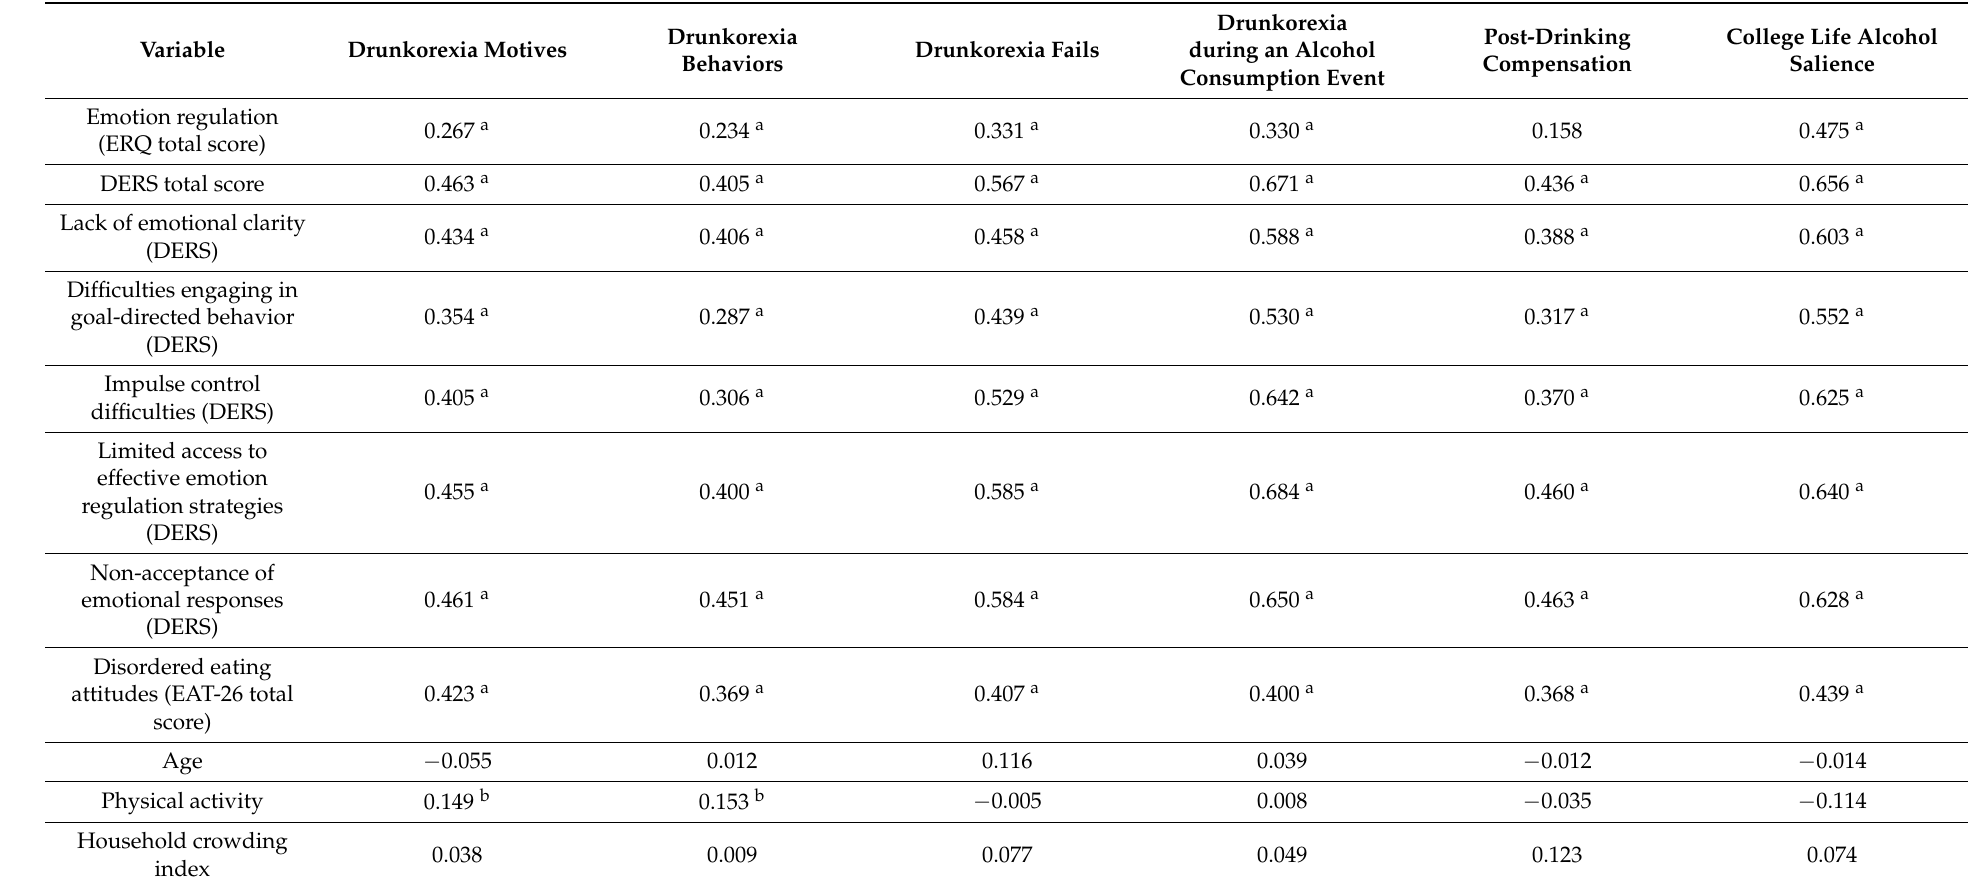
Table 2. Bivariate analysis of continuous variables associated with the drunkorexia